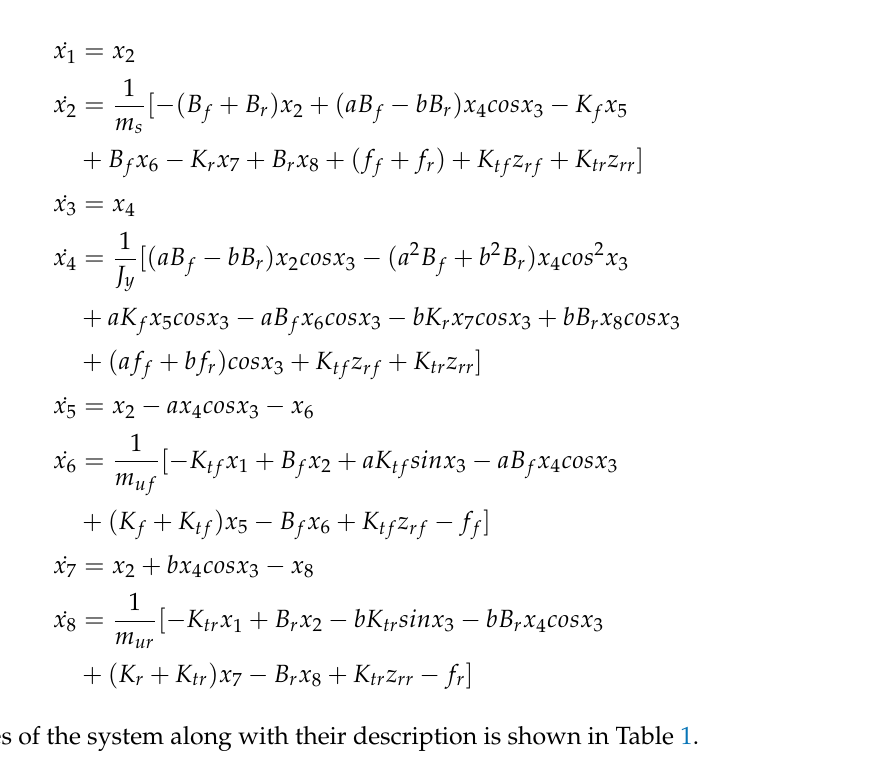
Table 1. State Variables and